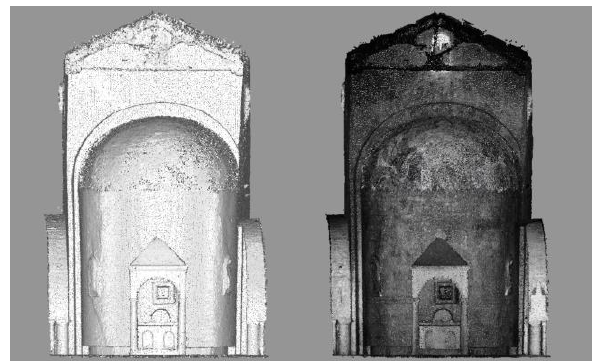
Figure 18. Hybrid point cloud generated from images of both Time 1 and Time